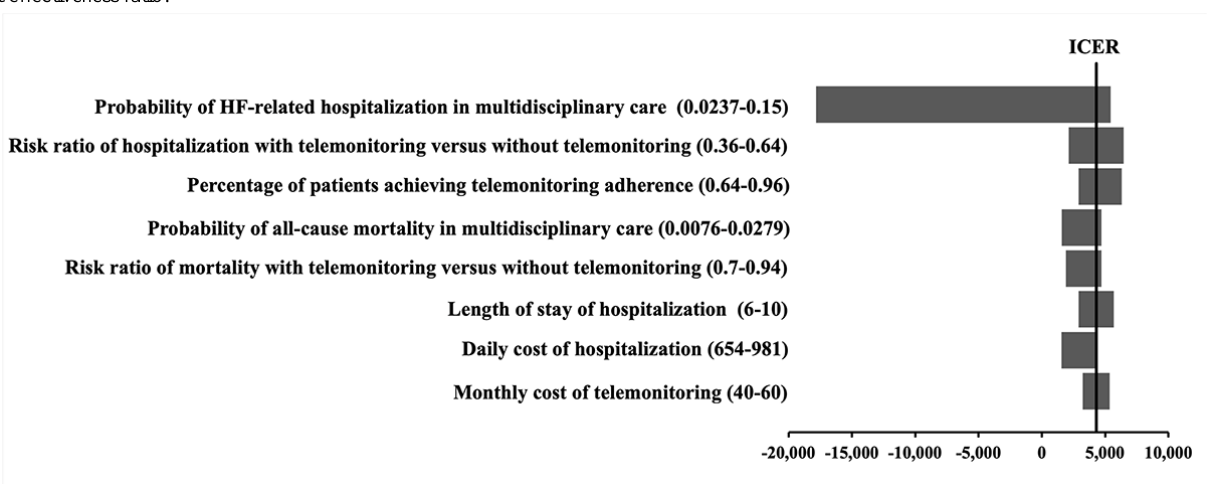
Figure 2. One-way sensitivity analysis of the ICER of the telemonitoring group versus the CUC group. CUC: care under COVID-19; ICER: incremental cost-effectiveness ratio.